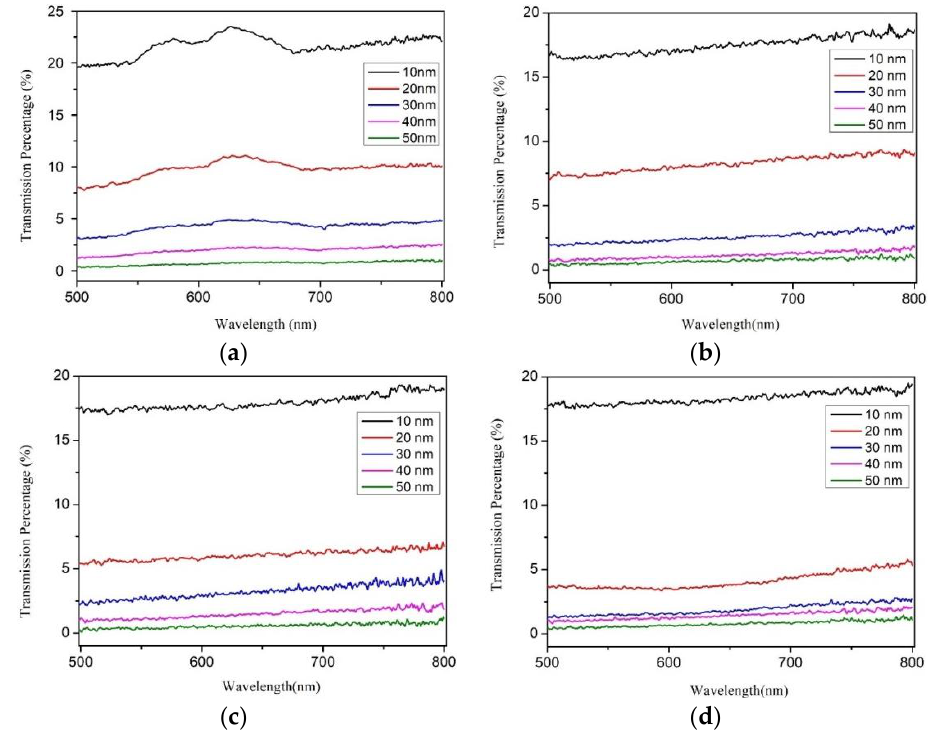
Figure 9. Transmittance (%) of Co 32 Fe 30 W 38 films. ( a ) At RT, ( b ) annealed at 300 °C, ( c ) annealed at 350 °C, ( d ) annealed at 400 °C.